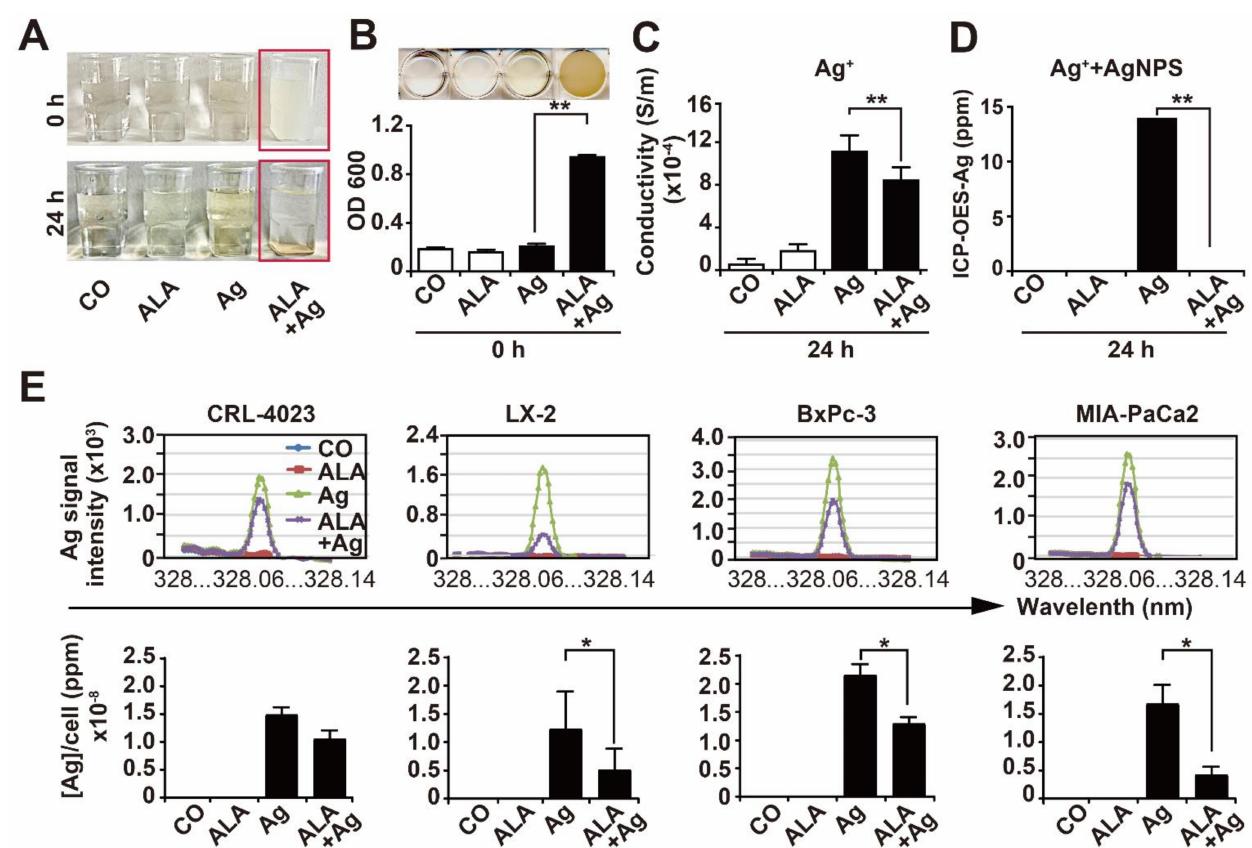
Figure 6. α -Lipoic acid chelates AgNPs and Ag ions. ( A ) A 20 mL H 2 O bidest solution containing final concentrations of 10 mM α -lipoic acid and 14 ppm AgNPs was prepared (ALA + Ag). Likewise, 20 mL H 2 O bidest alone, H 2 O bidest containing a final concentration of 10 mM α -lipoic acid (ALA) or the final concentration of 14 ppm AgNPs (Ag) were prepared. Twenty-four hours later, representative images were taken. ( B ) The optical density of each aqueous solution was measured at 600 nm by a Biotek EL800 microplate reader, and the mean data ± SD are shown in a diagram. ( C ) Likewise, the presence of Ag + ions was indirectly detected via conductivity measurements in each aqueous solution. The experiments were measured by the use of an HP8753C network analyzer in combination with an HP86046 A S-parameter test set and analyzed as described in the Materials and Methods. The data obtained from at least three independent experiments and results are shown as Siemens per meter (S/m) ± SDs. ( D ) The concentration of total silver (AgNPs and Ag + ions) was measured by ICP-OES, and the mean concentrations are shown as ppm ± SD. ( E ) CRL-4023, LX-2, BxPc-3 and MIA-PaCa2 cells were seeded into cell culture dishes at a density of 8 × 10 4 mL and incubated for 24 h. Then, the cells were precultured with a final concentration of 1 mM α -lipoic acid (ALA). After incubation for an additional 24 h, the medium of the ALA precultured cells was changed, and the cells were treated with a final concentration of 1.4 ppm AgNPs for 24 h or were left untreated in the control. The cells were dissolved in 65% HNO 3 for 24 h, and the AgNP concentration was determined by ICP-OES. The data obtained from at least three independent experiments and the diagrams with the obtained mean data ± SD are shown. * p < 0.05, ** p <